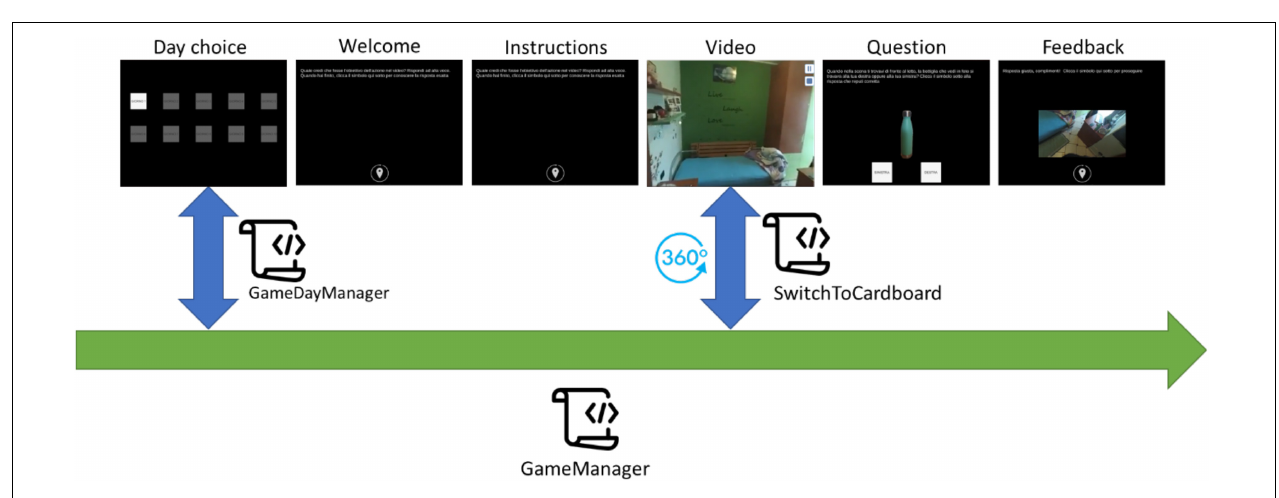
FIGURE 2 | Architecture of the